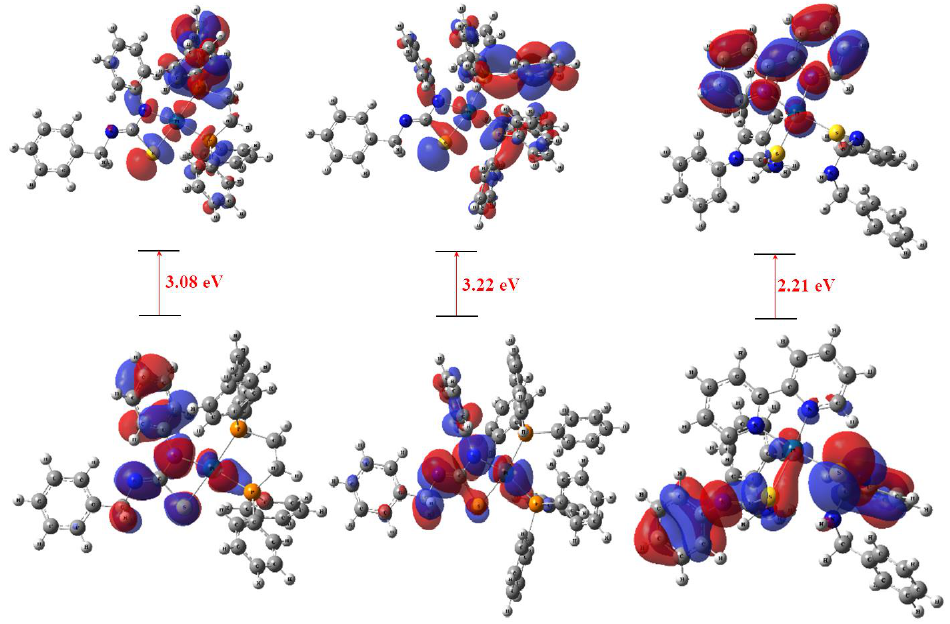
Figure 3. HOMO and LUMO for ( a ) [Pt(BPT)(dppe)] ( 1 ), ( b ) [Pt(BPT)(PPh 3 ) 2 ] ( 5 ), ( c ) [Pt(BPT) 2 (Bipy)] ( 7 ).